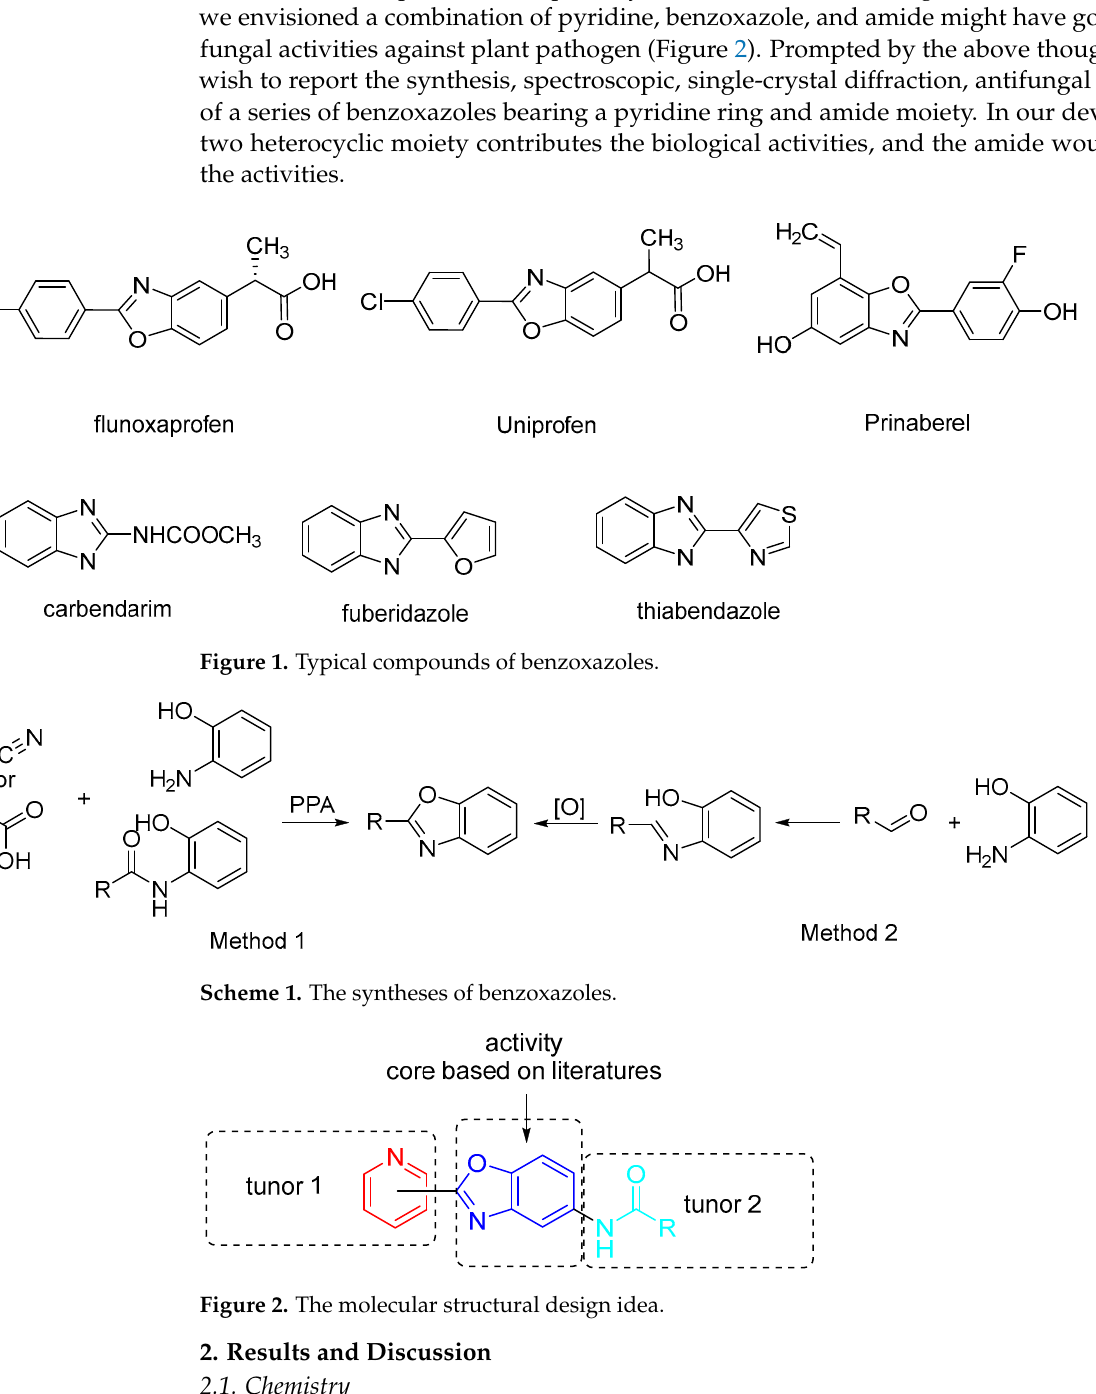
Figure 1. Typical compounds of benzoxazoles.